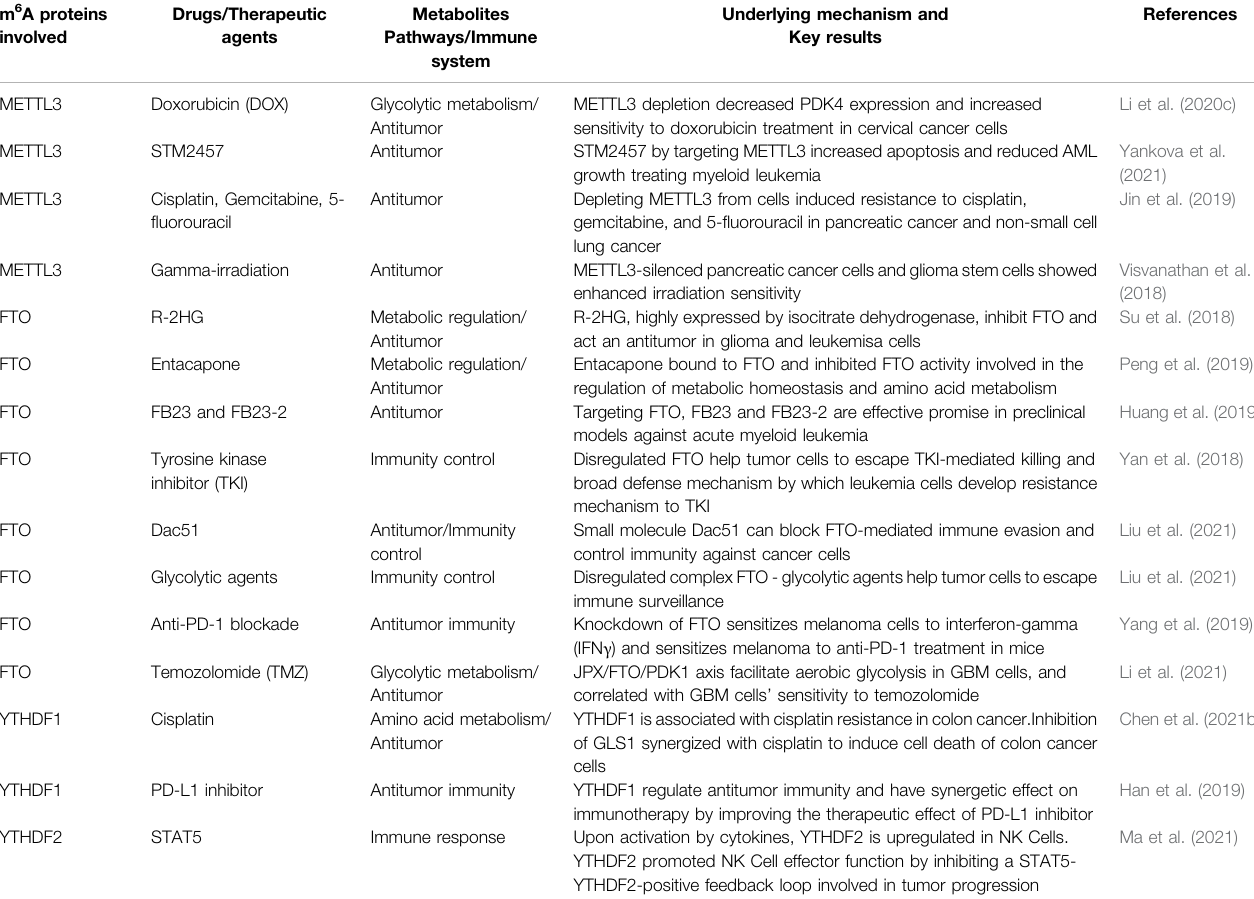
TABLE 3 | Non-exhaustive list of Potential alternative therapeutic agents offers by m 6 A targeting modi fi cations in